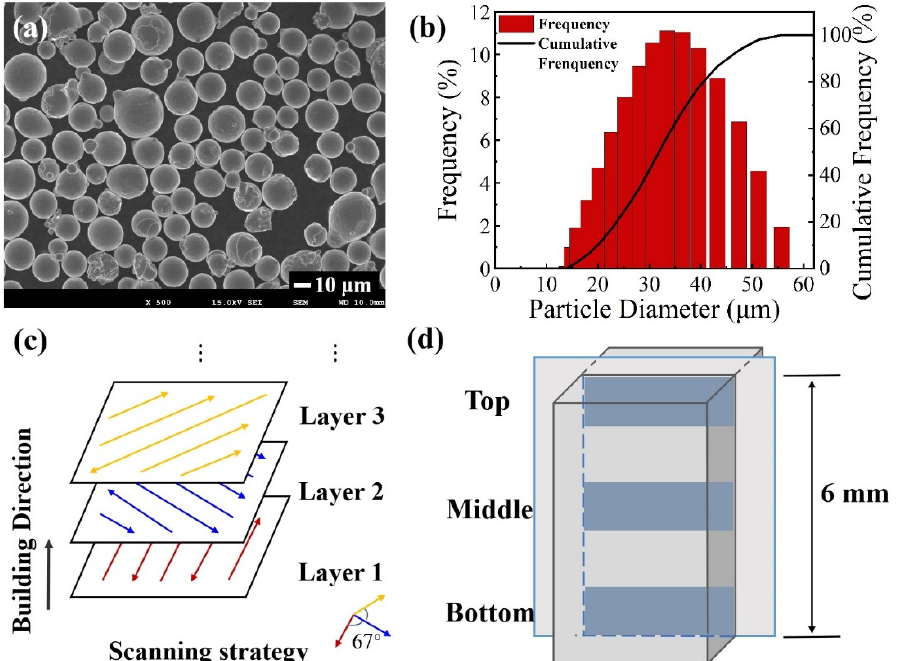
Figure 1. ( a ) Morphology of the FGH96 powder; ( b ) particle-size distribution; ( c ) scanning scheme for the layer-by-layer SLM process; ( d ) specimens chosen from different positions of the SLMed sample.